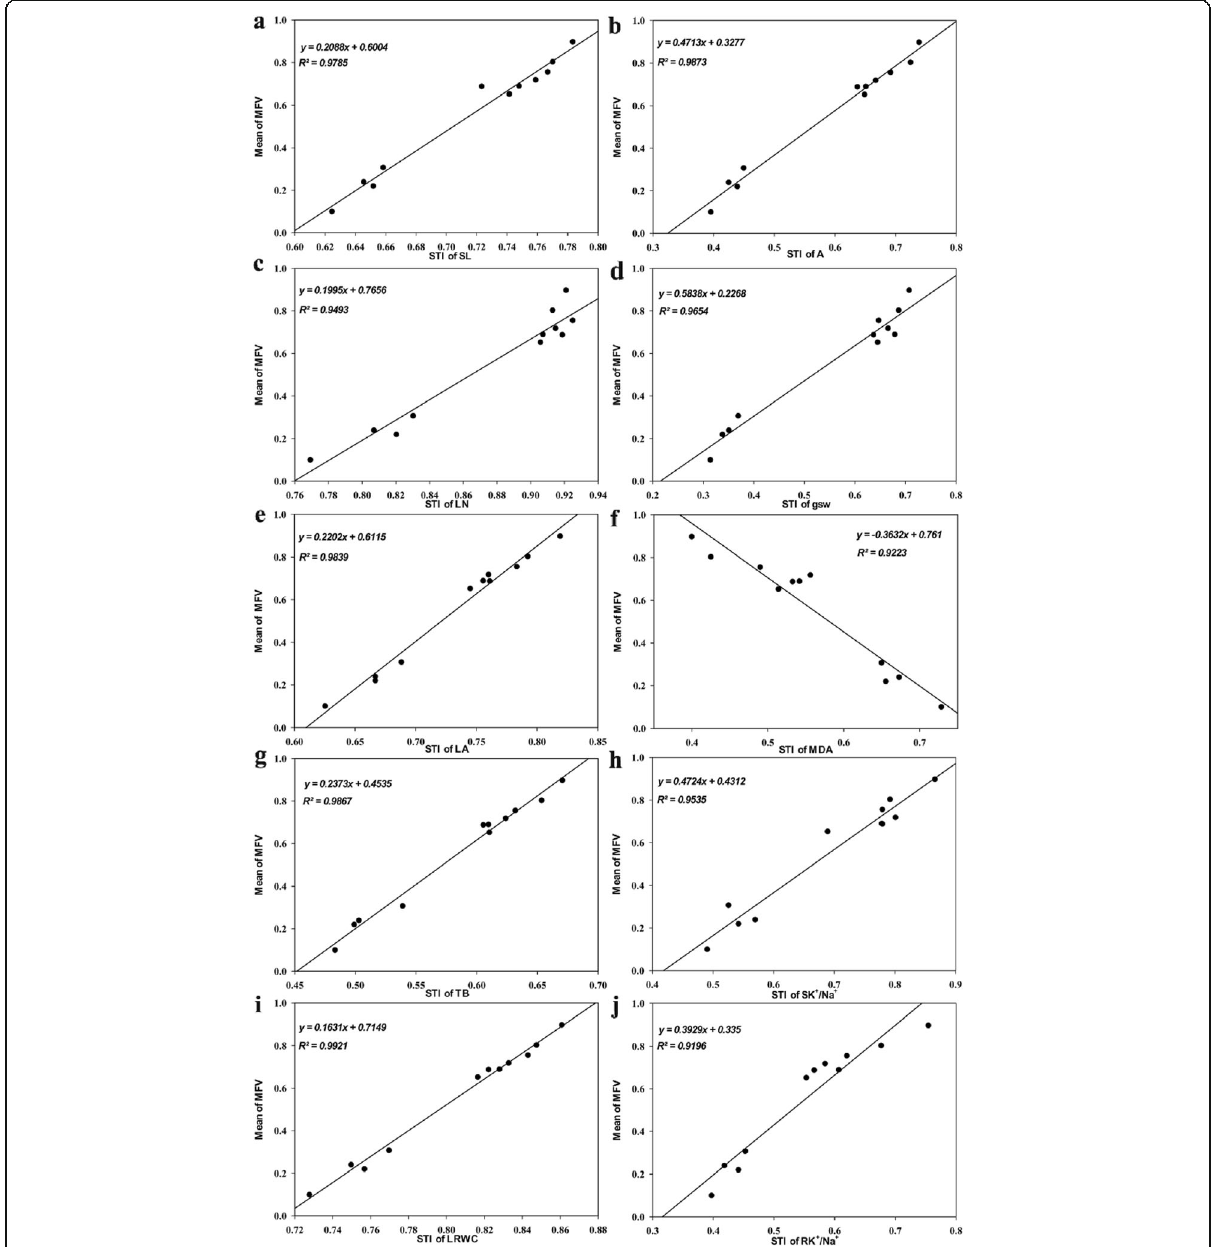
Fig. 4 The linear fit regression between STI of each morpho-physiological trait and mean MFV of cotton